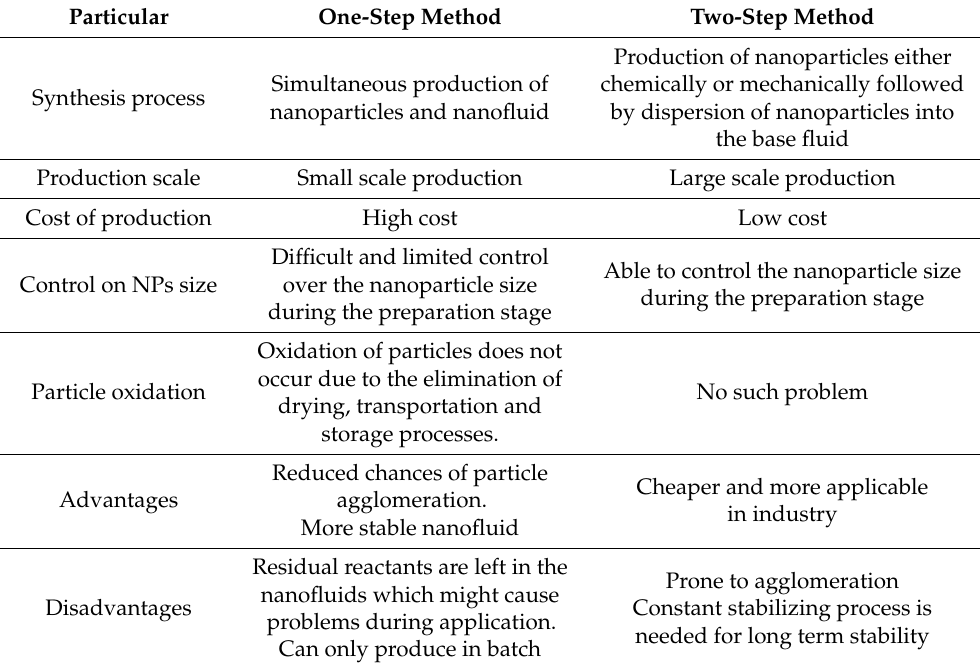
Table 2. Summary of differences between one-step and two-step